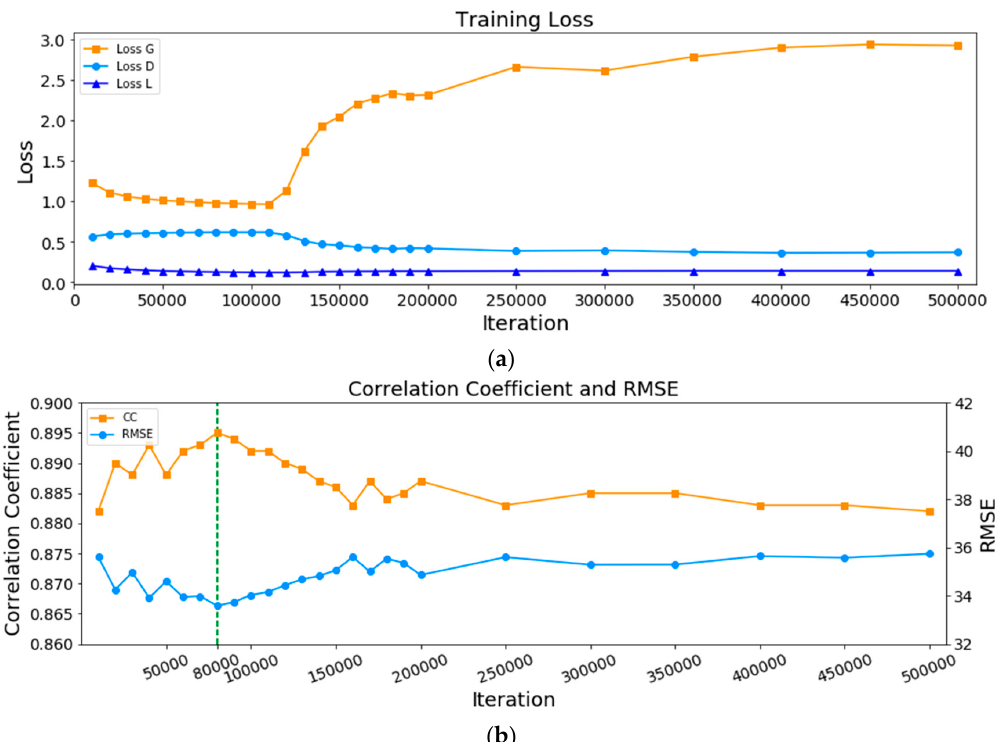
Figure 4. (a) Values of loss G, loss D, and loss L1 as a function of iterations for artificial intelligence (AI)-generated reflectance. (b) Variations in correlation coefficient (CC) and root mean square error (RMSE) between the real VIS reflectance and AI-generated VIS reflectance. Figure 5. The results of our model. Figures 5a,b show a COMS-observed real daytime reflectance in the COMS VIS (0.675 μ m) band and a daytime radiance image in the COMS IR1 (10.8 μ m) band on August 22, 04:00 UTC (13:00 KST), respectively. Figure 5c shows the AI-generated daytime reflectance image at the same time as those in Figure 5a,d show the difference image between the COMS- observed real daytime reflectance and the AI-generated daytime reflectance. The real COMS reflectance image and AI-generated reflectance image agree well except for near the typhoon area of high clouds which appear white. In this case, our models were implemented using 80,000 iterations.